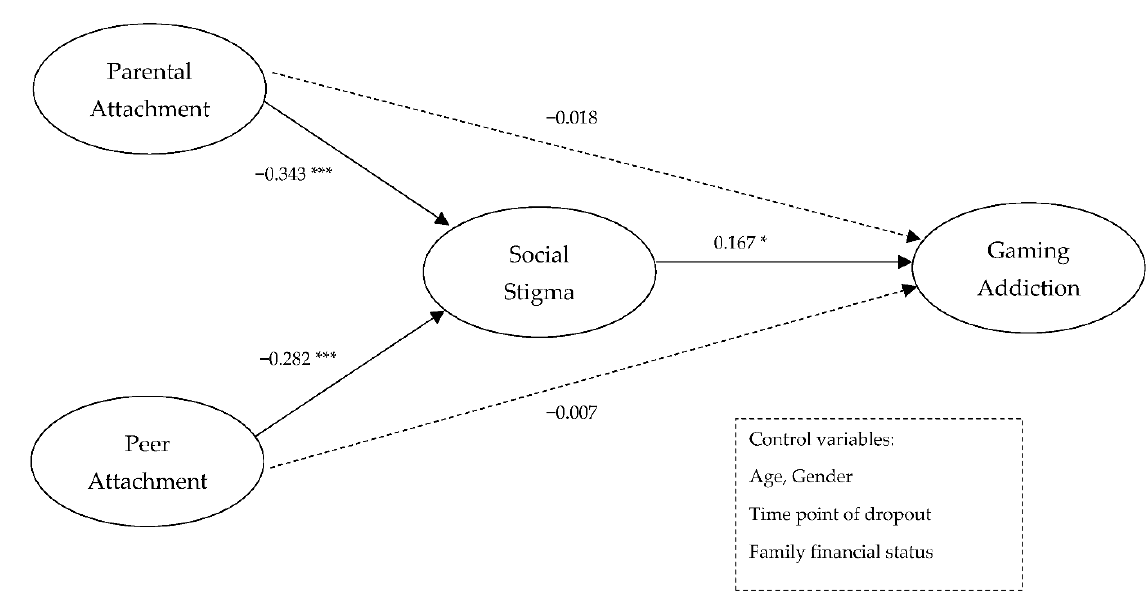
Figure 2. Structural equation model of parental and peer attachment, social stigma, and gaming